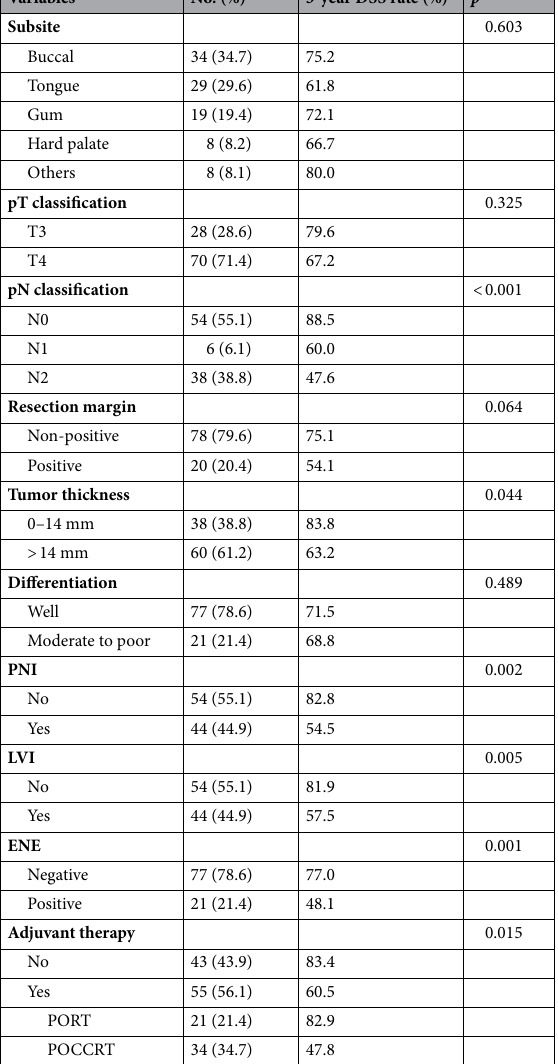
Table 1. Clinicopathologic features of the 98 patients with T3–4 oral squamous cell carcinoma. PNI perineural invasion, LVI lymphovascular invasion, ENE extranodal extension, PORT postoperative radiotherapy, POCCRT postoperative concurrent chemoradiotherapy. *Log-rank